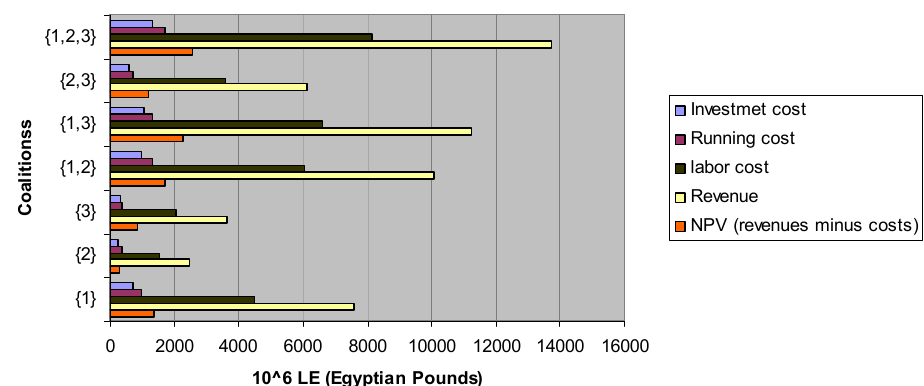
Figure 3. Present values of cost and revenues games under Alternative A0. Investment cost: Present values of coalitions in the investment cost game i A0 . Running cost: Present values of coalitions in the running cost game i A0 . Revenue: Present values of coalitions in the revenue game V A0 . NPV (revenues minus costs): Total net present value obtained as the difference between revenues and costs.